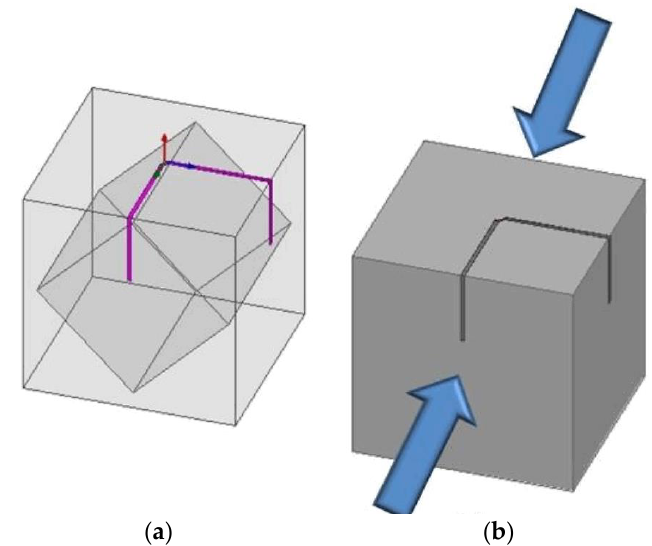
Figure 10. ( a ) 3D antenna on a hollow cube; and ( b ) directions in which strain is applied on the front and the back surfaces of the cube [18].